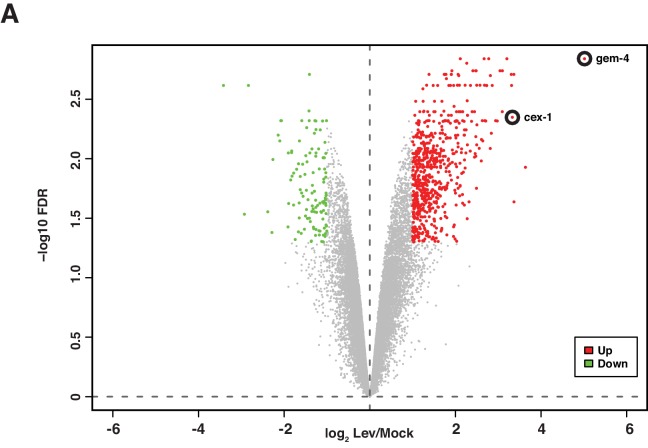
Analysis of mRNA abundance following muscle depolarization.mRNA abundance in Lev (200 µM, 1 hr) versus mock treated synchronized L4 larvae is plotted. Fold change (x-axis) is plotted against the statistical significance (y-axis) for each probeset. Fold changes are shown in log2 scale. Adjusted P values are shown in - log10 scale. Genes with increased (red dots) and decreased (green dots) expression are indicated (>2 Fold-change, FDR p<0.05). Probe sets corresponding to gem-4 and cex-1 are indicated. All genes that are differentially expressed following Lev treatment are listed in Supplementary file 2.